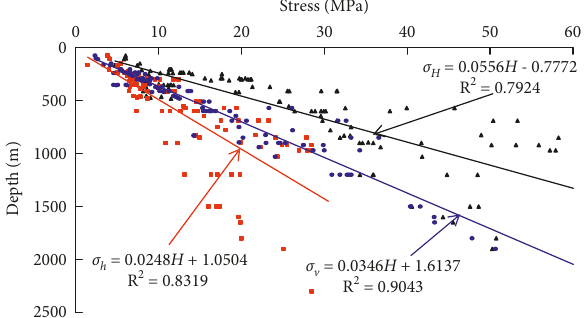
Figure 4: Variation of principal stress with